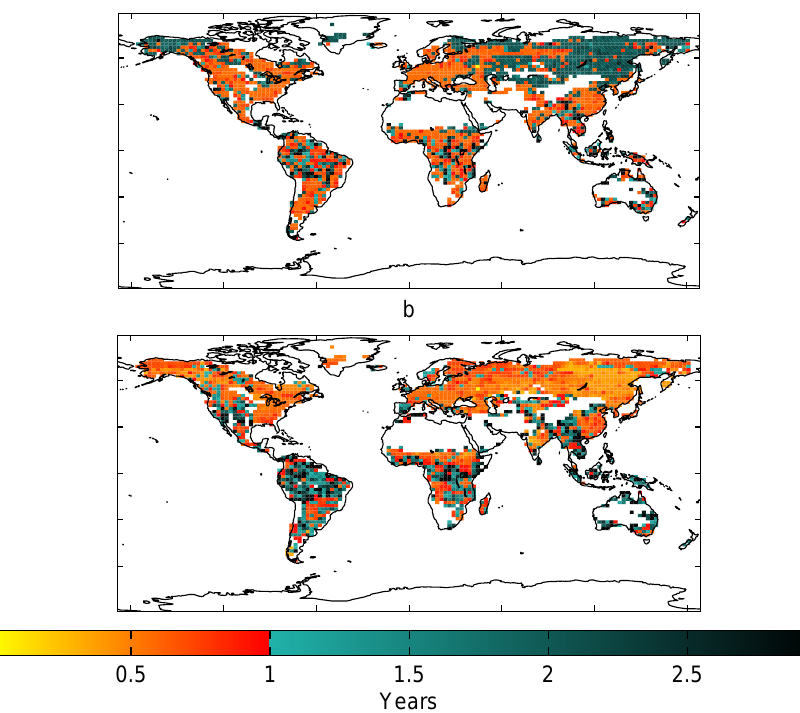
Fig. A3. (a) Posterior parameter value for leaf ageing limit a crit and (b) realised age of oldest leaves